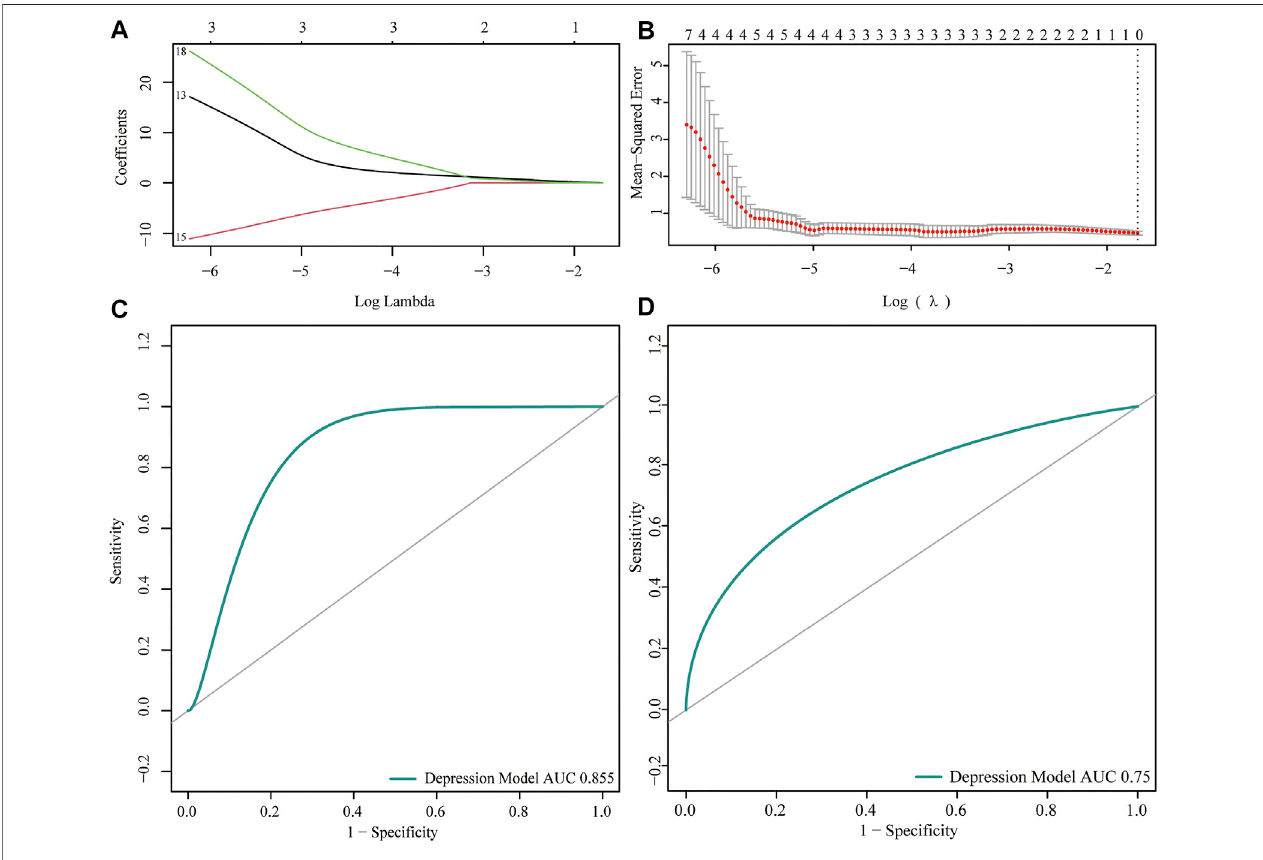
FIGURE 4 | Predictive power analysis of neural network models for depression. (A,B) LASSO regression analysis identi fi ed key genes for m6A regulators. (C) Receiver operating characteristic (ROC) curve of the neural network model test set; the abscissa represents the speci fi city and ordinate represents the sensitivity. (D) ROC curve of the validation set of the neural network model; the abscissa represents the speci fi city and ordinate represents the sensitivity.